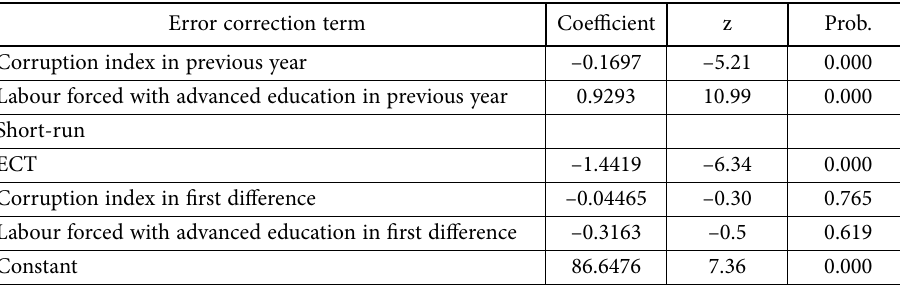
Table 12. Panel ARDL model to explain FDI in Poland, Czech Republic and Slovakia (2005–2016) (source: own results) Error correction